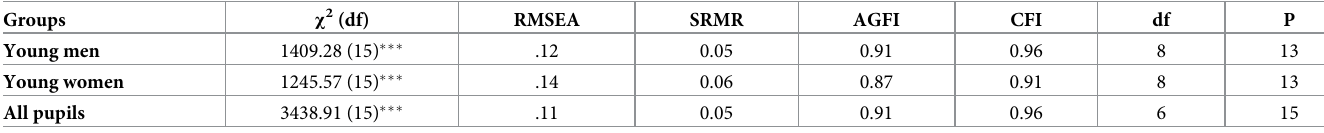
Table 3. Overview circumplex goodness of fit